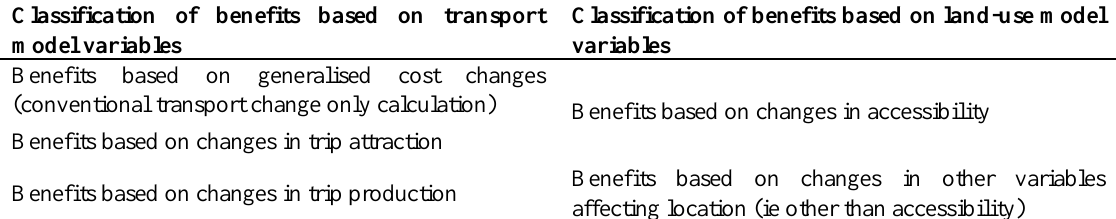
Table 2. Equivalence of benefits calculated from transport or land-use variables Classification of benefits based on transport model variables Benefits based on generalised cost changes (conventional transport change only calculation) Benefits based on changes in trip attraction Benefits based on changes in trip production